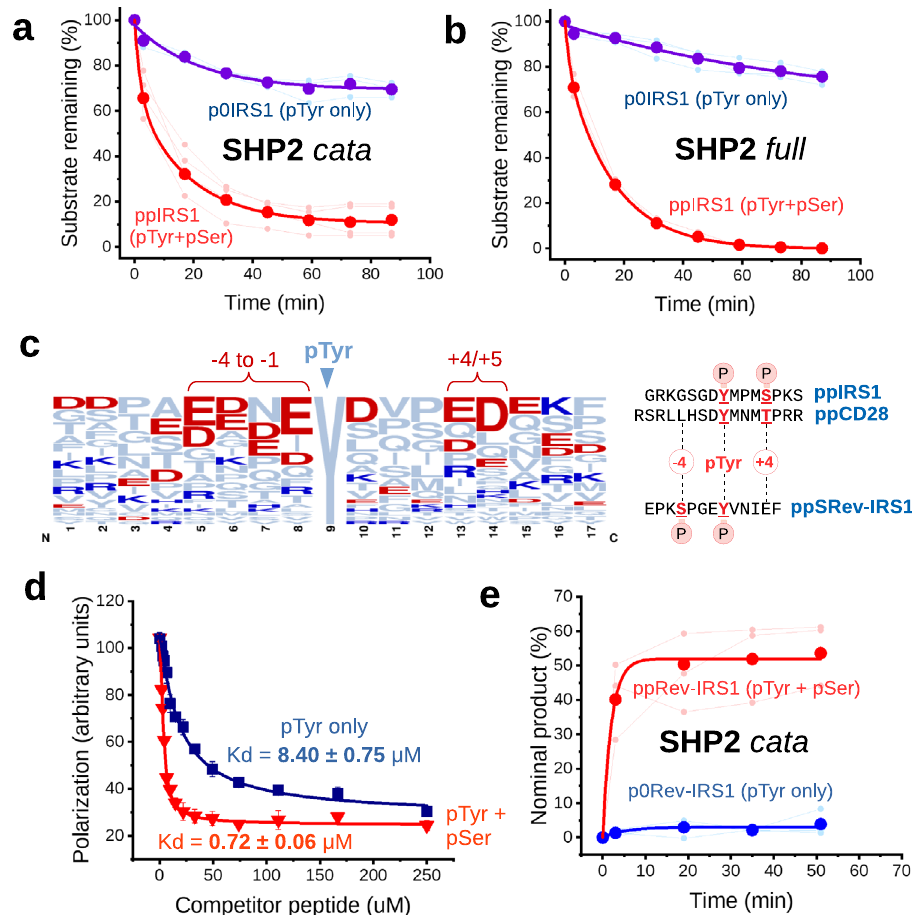
− 4 to − 1. These sites correspond to Ser/Thr phosphorylation sites in our peptides. d Fluorescence polarization assays with the tyrosine phosphorylated or dually phosphorylated SRev-IRS1 peptides show an enhancement of binding comparable to+4Ser/Thrphosphorylatedsubstrates( n =3technicalreplicates,withmean±SD displayed for each point). e Dephosphorylation assays monitoring the product formation(expressedas%ofsubstratepeaks)showingsuperiorreactionrateswith the doubly-phosphorylated ppRev-IRS1 peptide versus its phosphotyrosine-only counterpart (p0Rev-IRS1) ( n =3 for both curves). Thin lines and small points show individualexperiments,whilethethicklinesareexponentialcurves fi ttedovertheir means (large dots). Source data are provided as a Source Data fi